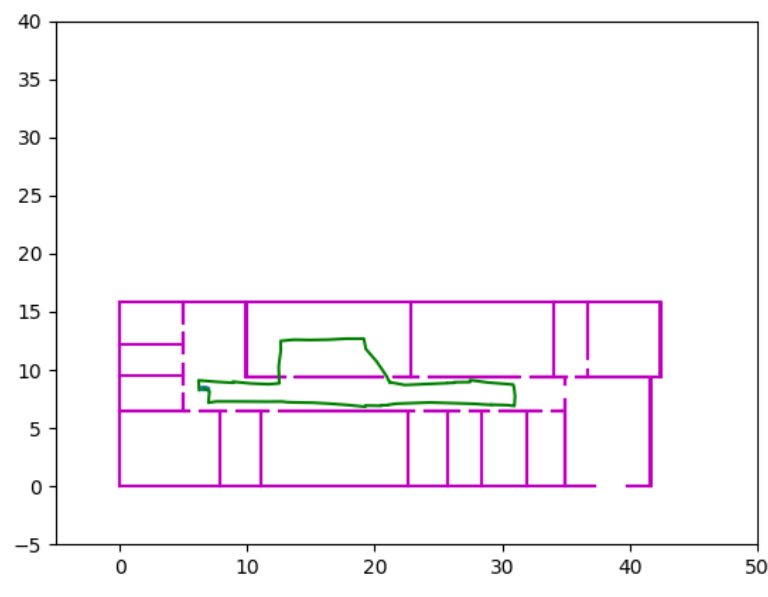
Figure 6. A path corrected by the map matching algorithm. The axes are defined in meters [m].